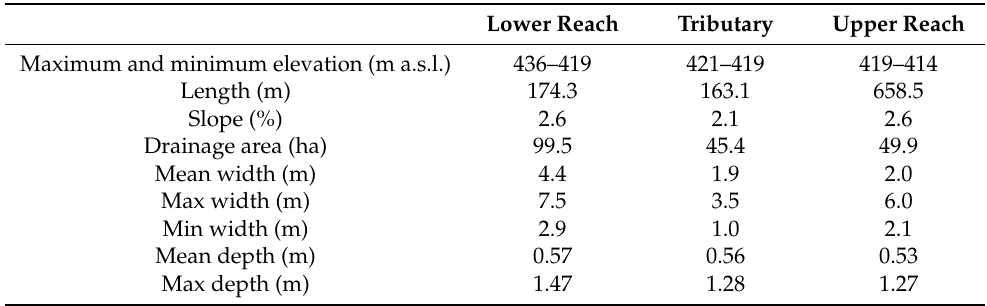
Table 1. Characteristics of the channel reaches belonging to unmanned aerial vehicle (UAV) survey completed in January 2019.